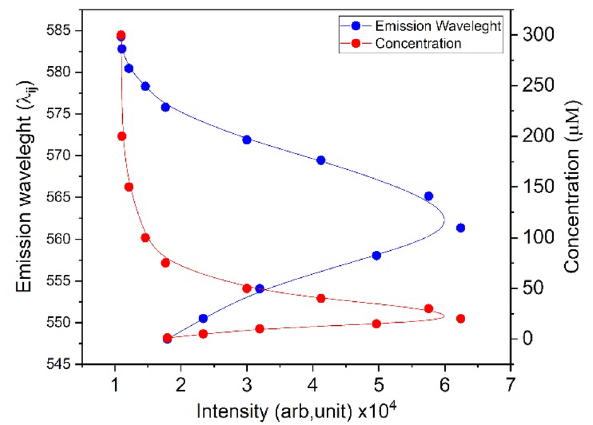
Figure 4. Emission wavelength and Rd6G concentration in terms of fluorescence signal